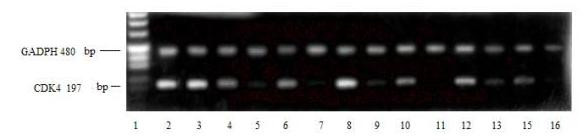
An ethidium bromide-stained 2% agarose gel for CDK4 gene amplification, lane 1: molecular weight marker (MW), lanes 2–7: cases of invasive squamous cell carcinoma, lanes 8–12: CIN cases, lanes 13–14: normal cervical tissue samples, lane 15: a negative control. Lanes 2, 3, 8 show CDK4 gene amplification.